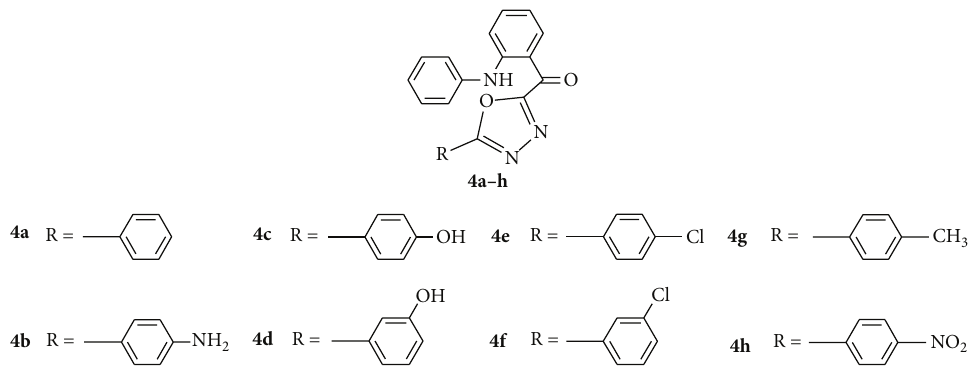
Figure 1: N-Phenyl anthranilic acid-based substituted 1,3,4-oxadiazole analogues ( 4a–h